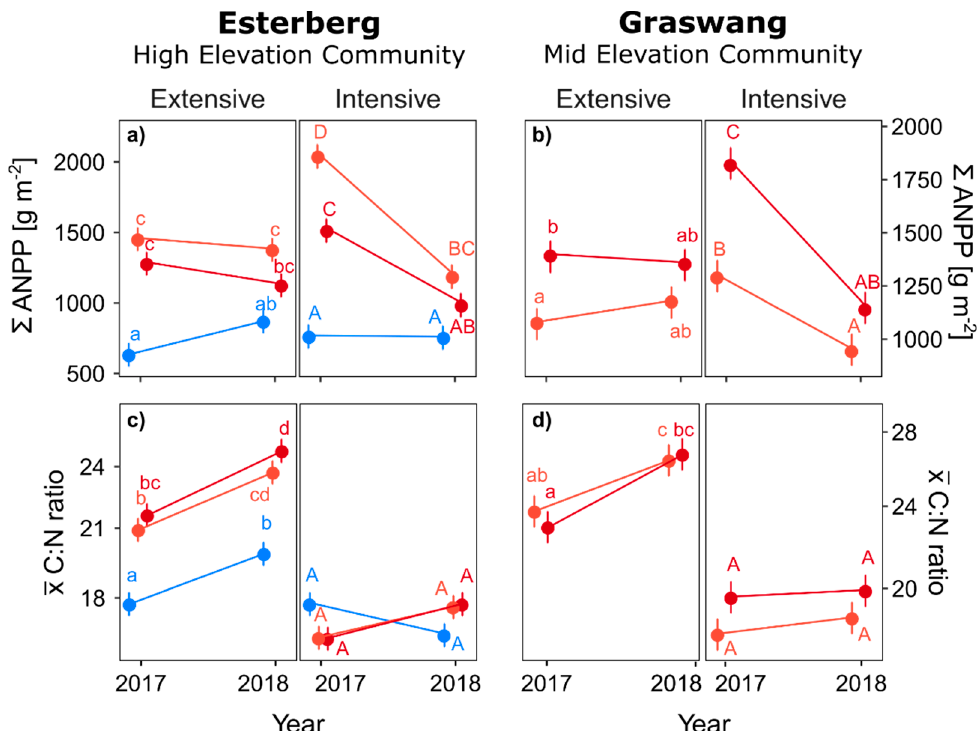
Figure 2. Yearly ANPP ( a , b ) of extensively managed (left column of a, b, c, d) communities of both high-elevation ( a , c ) and mid-elevation ( b , d ) origin remains stable over the two years of study, contrasted with the significant decline in ANPP of intensive managed (right column of a, b. c, d) communities in 2018. The C:N ratio ( c , d ) is higher under extensive management, and increases in 2018, in contrast to a constant low C:N ratio of intensively managed communities. Shown are mean and standard deviation. Letters indicate significant ( p < 0.05) differences within panel. Colours match recipient site colour code of Figure 1.